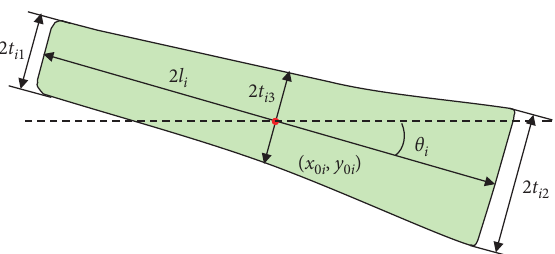
Figure 2: Geometry description of the quadratically variable component.